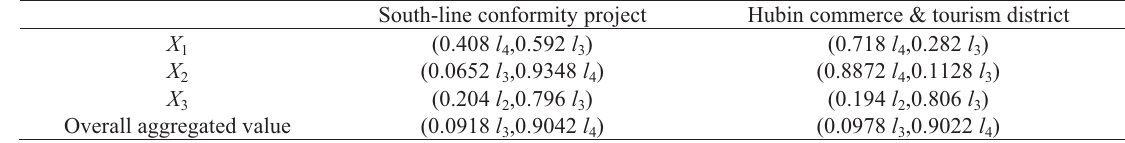
Table 5. The functions degree using